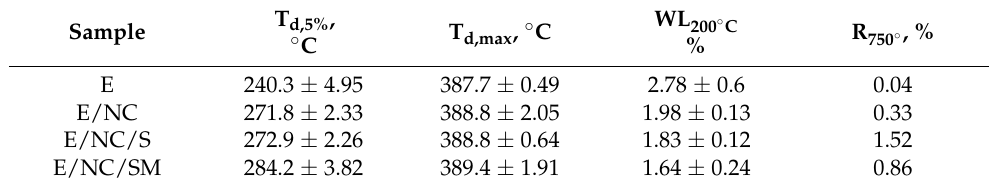
Scheme 1. Illustration of proposed crosslinking mechanism of ELO resin with IA in the presence of grafted (NC/SM) and ungrafted (NC) nanofibrillated cellulose.